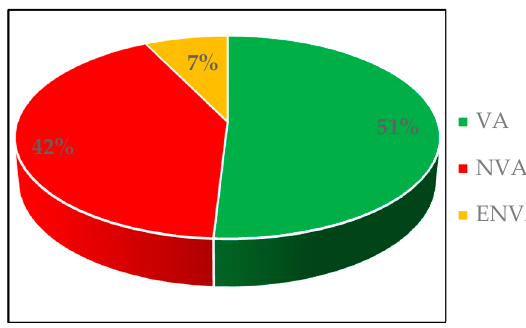
Figure 4. Summary of the VSM data of the process “installation of a bracket”.